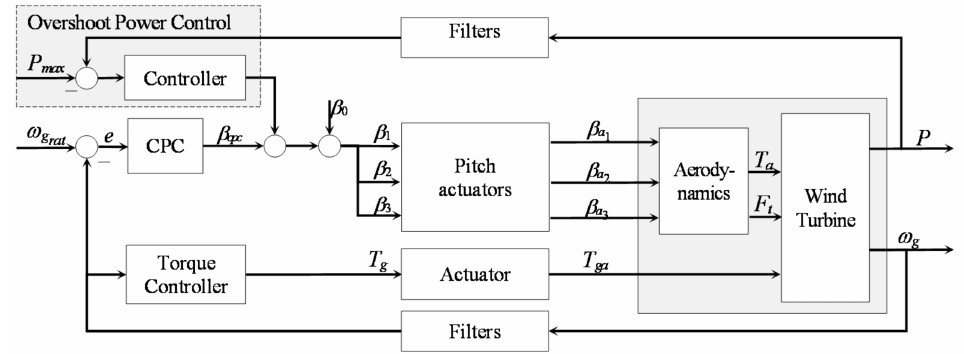
Figure 5. Power delimiter control as additional control loop for the collective pitch control